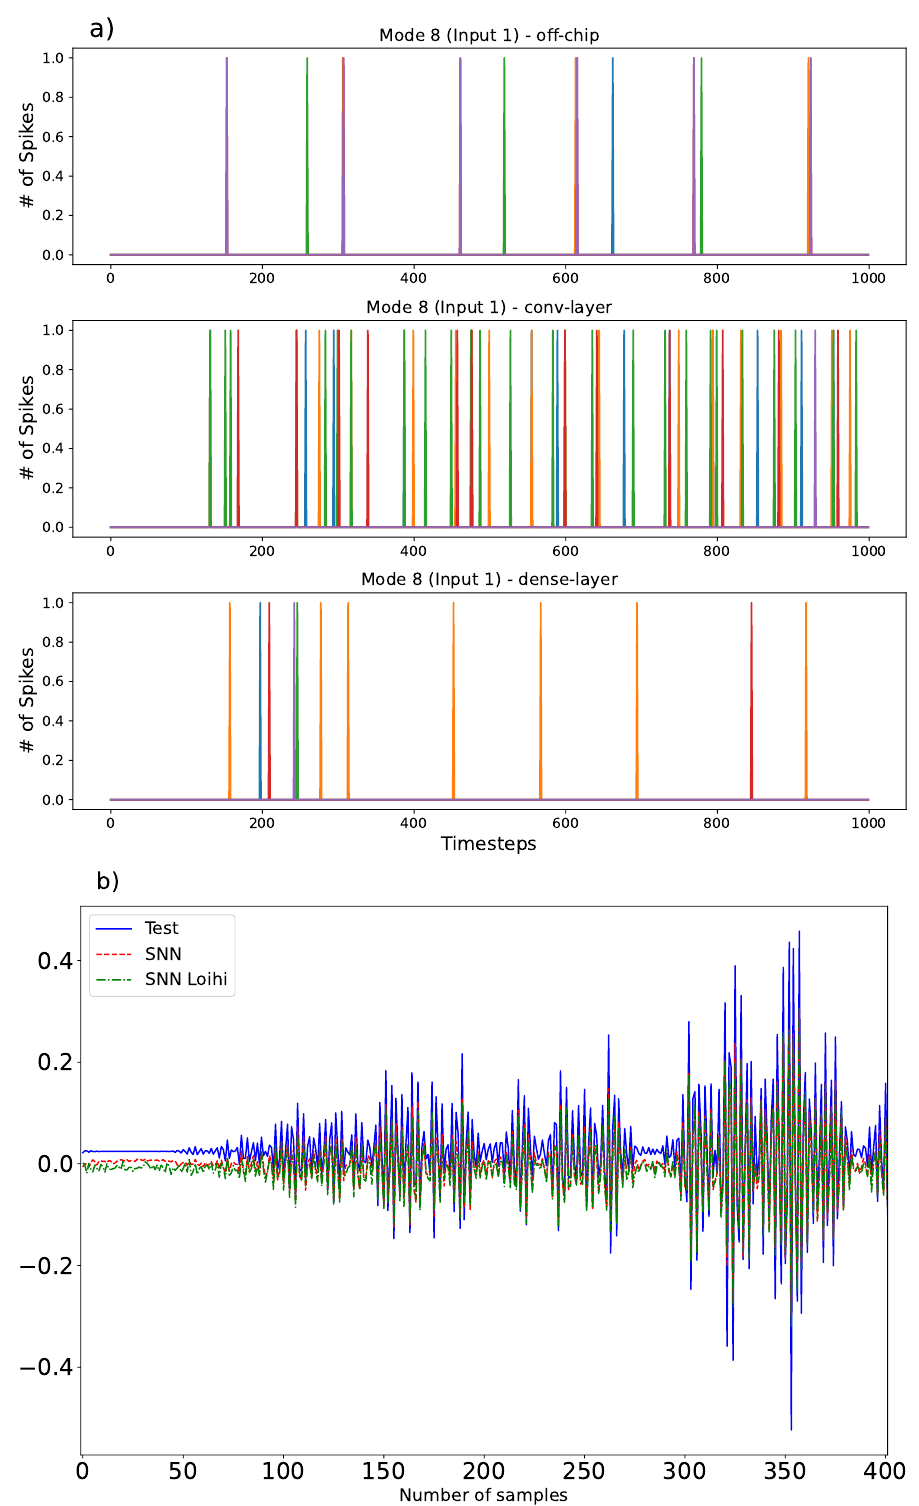
Figure 14. Results for mode 8: ( a ) Neural activities of 5 neurons of each layer. One input vector is shown over 1000 timesteps. ( b ) Predictions over the testing set with the SNN architecture (dashed red line) and running the SNN on the Loihi emulator (dash-dot green